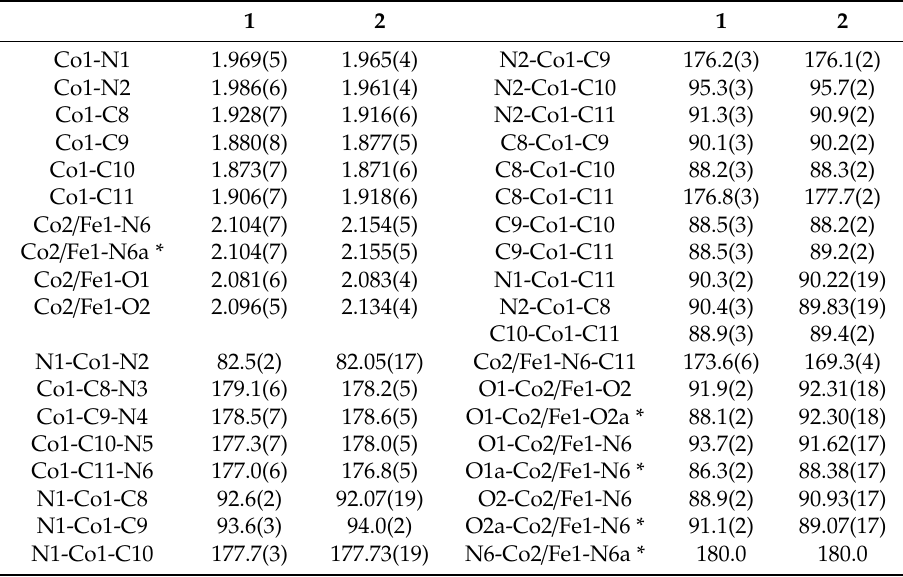
Table 1. Bond lengths (Å) and angles (deg) of the cobalt(II / III) ( 1 ) and cobalt(III) and iron(II) ( 2 ) coordination